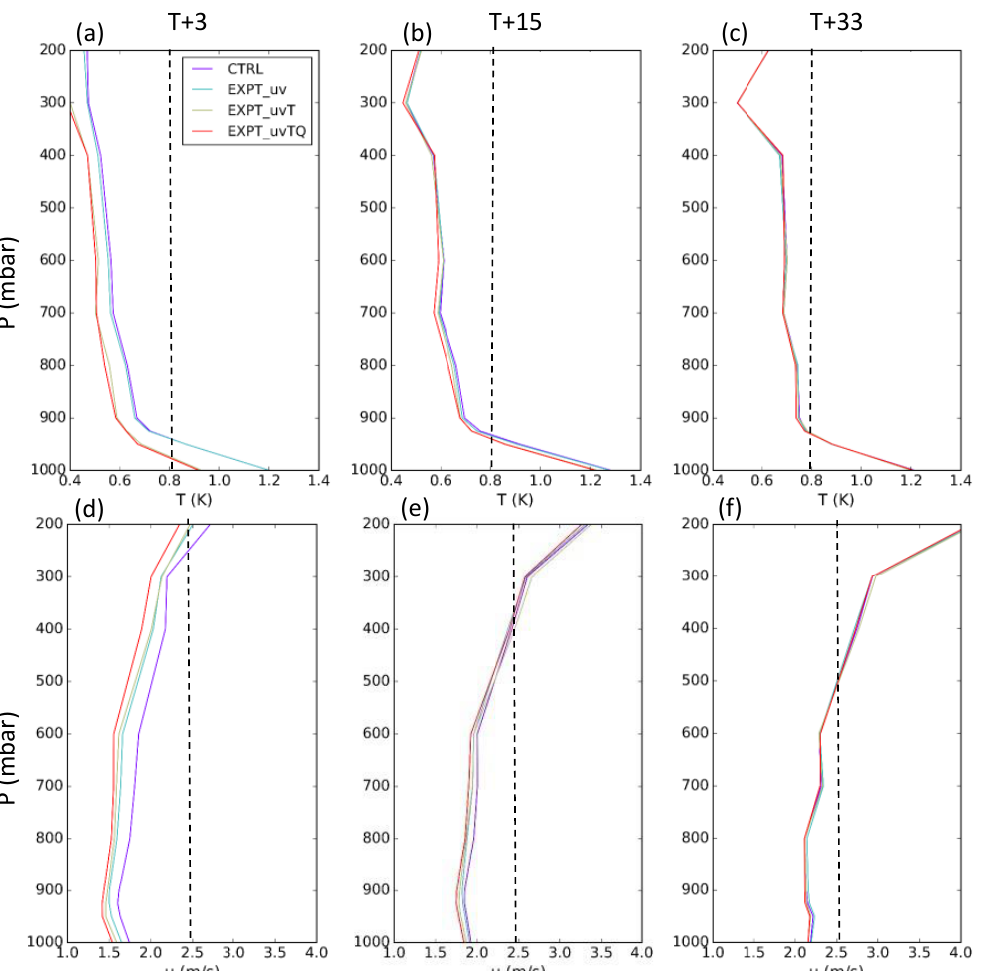
Figure 3. Vertical profiles of root mean squared error (RMSE) of temperature (T), in ( a – c ), and eastward wind (u), in ( d – f ), with respect to ECMWF analysis for CTRL and experiments at the indicated forecast lengths in hours. The vertical dashed line is at 0.8 K and 2.5 m/s in the top and bottom panels to assist in visualizing the increase in RMSE with the forecast.